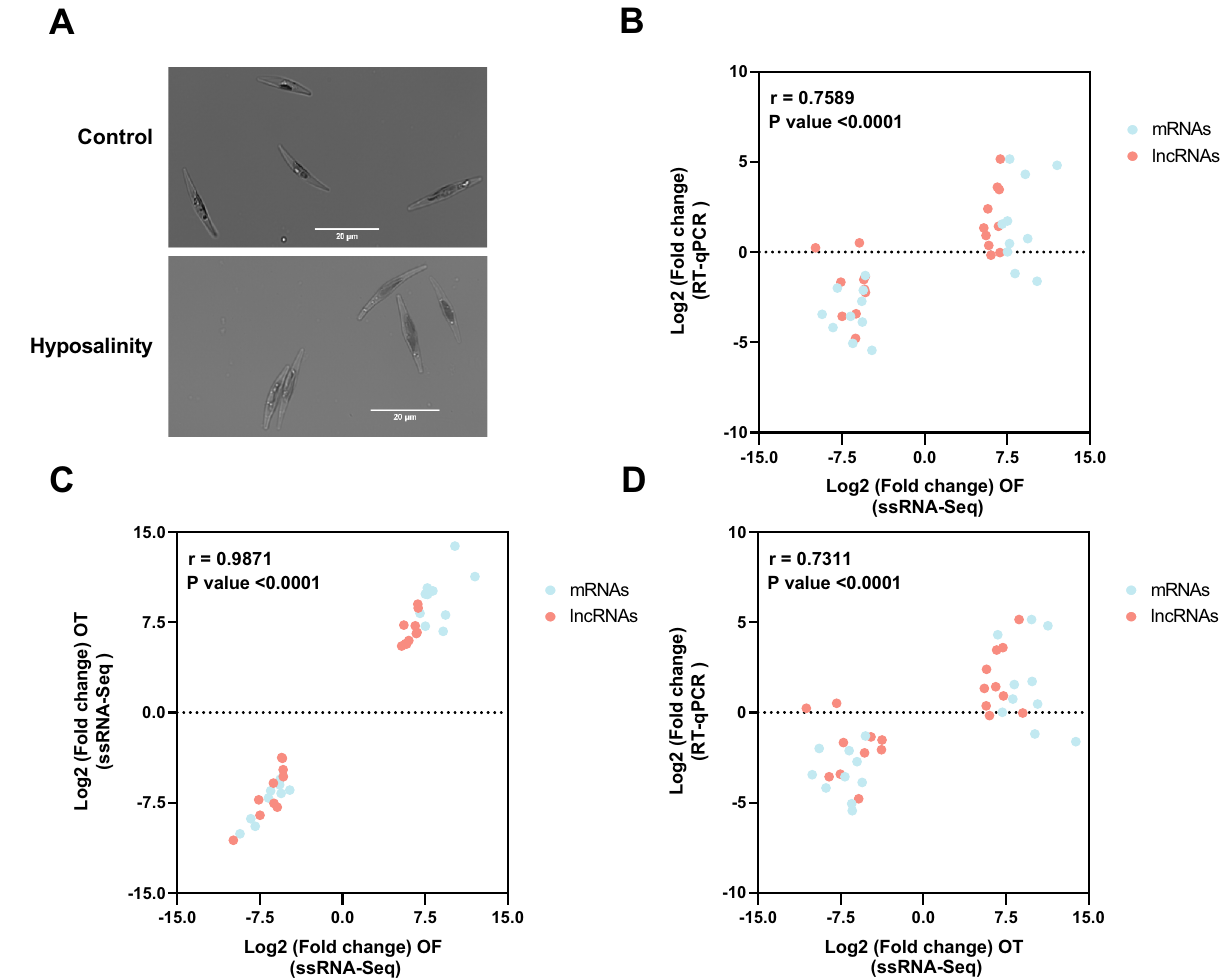
Figure 5. Analysis of the hyposaline effect compared to the impact of the morphotype in Pt1. ( A ) Culture of Pt1 at normal vs hyposalinity.After more than a year under hyposaline conditions, no shift in morphology was observed when compared to the control (100% seawater). ( B ) RT-qPCR vs RNA-Seq correlation of the top 40 DE selected genes in the OF pairwise comparison (Pt1 fusiform under hyposalinity conditions vs OF) r = 0.7589, P value < 0.0001. ( C ) Correlation of the expression profile of the 40 most DE selected genes in the OF with their expression profile in the OT, they show an almost perfect correlation (Pearson, r = 0.9871, p < 0.0001). ( D ) RT-qPCR vs RNA-Seq correlation of the 40 DE selected genes (fusiform under low salinity stress vs OT), Pearson correlation, r = 0.7309, P value < 0.0001. A 2 −ΔΔCt method was used for the normalization of the qPCR then a transformation was made to obtain the log2FoldChange. Correlation were performed using GraphPad Prism 9.4.1 analysis tool (Pearson correlation, P value Two-tailed, confidence interval